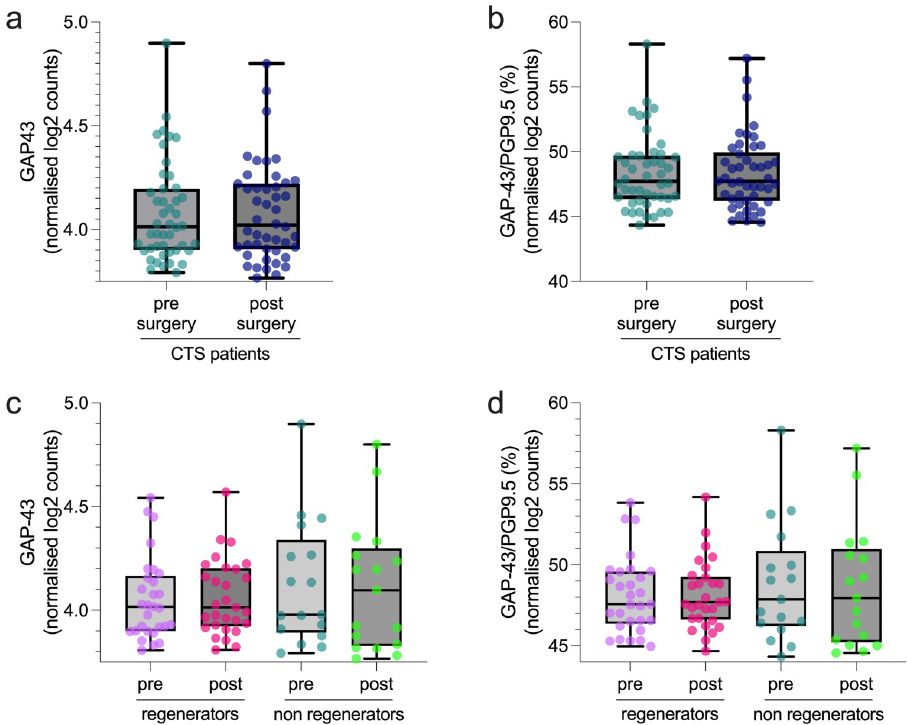
Fig 3. GAP-43 Gene expression. No difference in GAP-43 gene expression in skin of patients with CTS before and after carpal tunnel decompression. Normalised log2 counts of (A) Gap-43 and (B) GAP-43 gene expression expressed as a percentage of PGP9.5 gene expression are comparable before and after carpal tunnel surgery. No differences in (C) GAP-43 gene expression and (D) GAP-43 expressed as a percentage of PGP9.5 gene expression in skin of patients classified as regenerators and non-regenerators both before and after surgery.